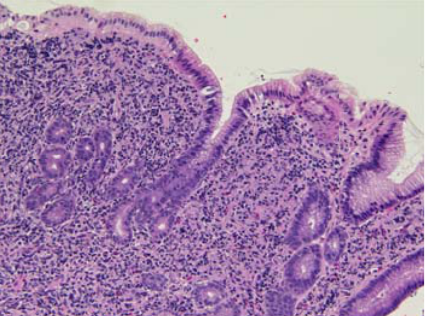
Figure 2: Histological image of stomach tissue biopsies from case 1. Dense, diffuse infiltration of small to medium-sized lymphoma cells was observed (hematoxylin and eosin staining, × 40). Lymphoep- ithelial lesions were